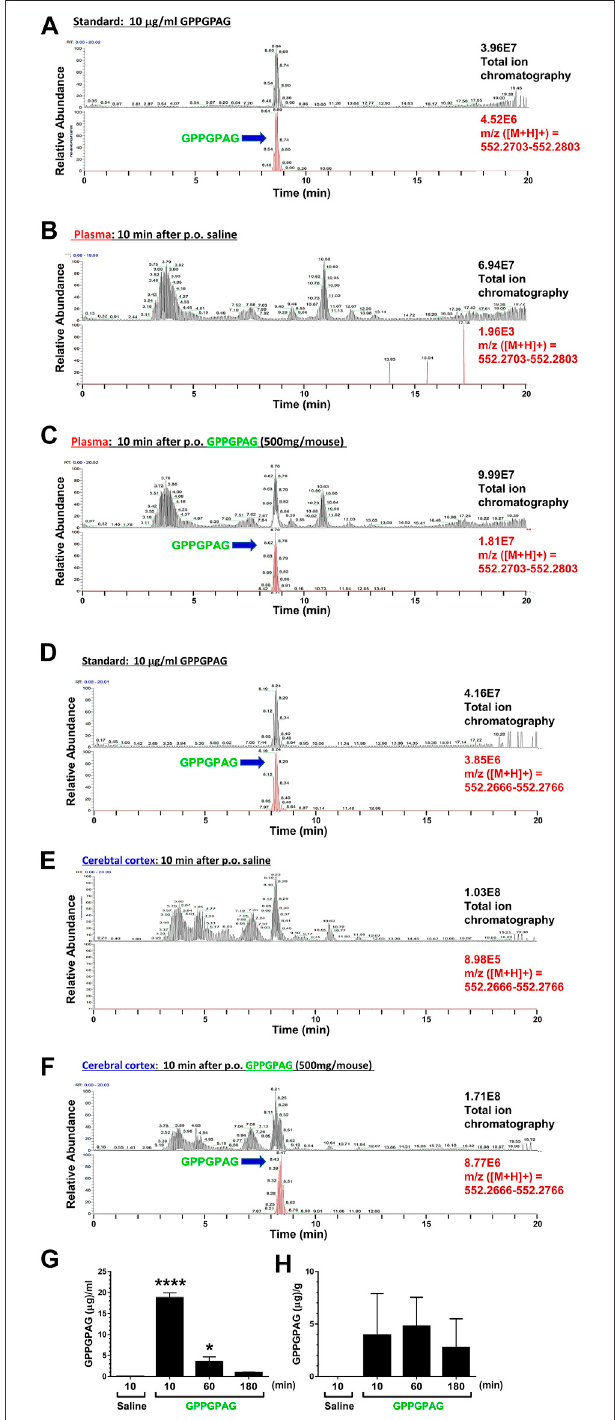
FIGURE 6 | Brain penetration of GPPGPAG after oral administration in mice GPPGPAG (500 mg/mouse, p. o.) or vehicle solution (physiological saline)wasadministeredtomice(ddY,females,8 weeksold, n (cid:2) 3)asasingle dose. Mice were sacri fi ced 10, 60, or 180 min after the treatment, and plasma and cerebral cortex was extracted with methanol and subjected to LC-MSanalysis. (A) Totalionchromatogram(upper)andextractedioncurrent